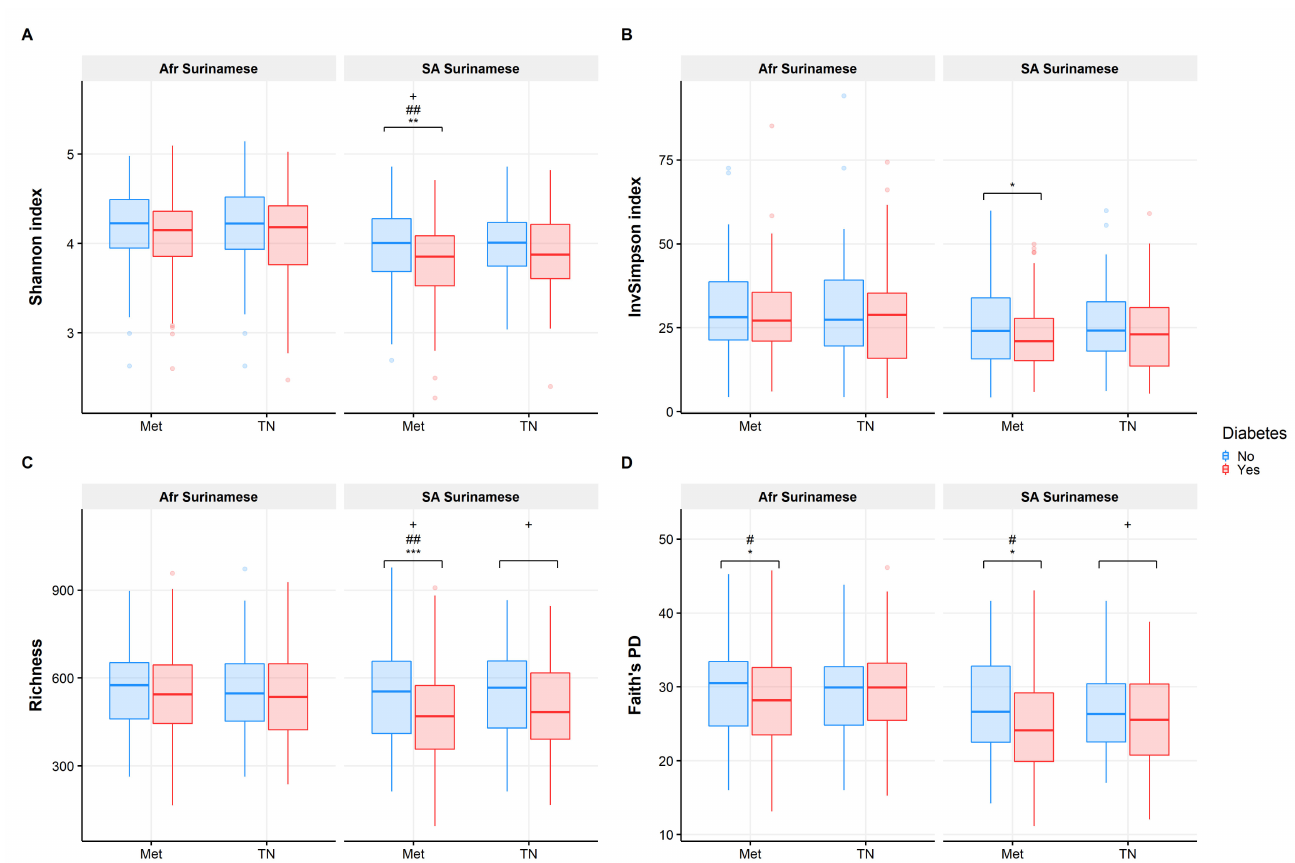
Figure 1. Overview of α -diversity measures in African and South-Asian Surinamese for the Met-T2D (Met) and TN-T2D (TN) datasets (T2D cases and matched controls) for ( A ) Shannon Index, ( B ) inverse Simpson index, ( C ) richness and ( D ) Faith’s PD. Significant differences are indicated with different symbols for different models: * (no adjustment for confounders), # (adjustment for age, sex and BMI) and + (adjustment for age, sex, BMI and medication use) and different number of symbols for different significant levels (*/#/+ = p ≤ 0.05, **/##/++ = p ≤ 0.01 and ***/###/+++ = p ≤